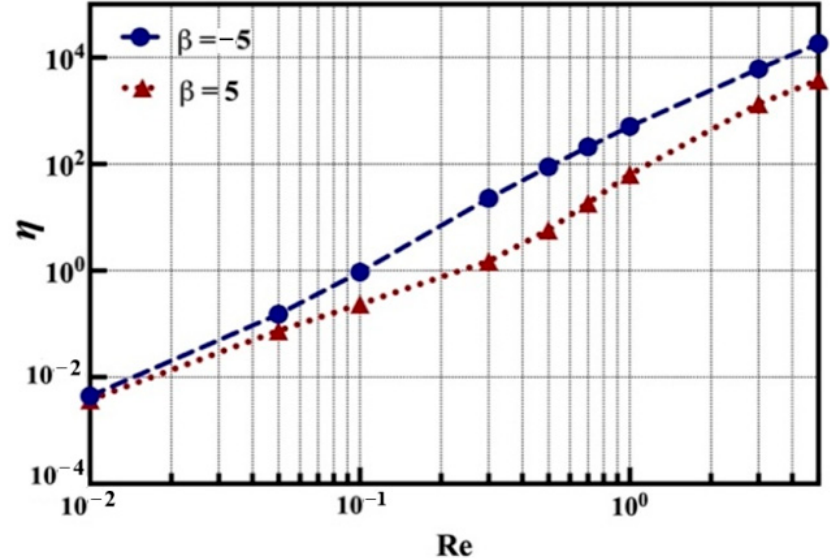
Figure 10. Relationship between η and Re.